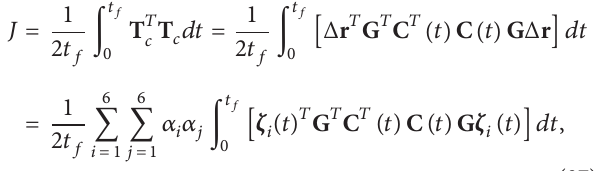
three osculating imaginary eigenvalues ±𝜔 1 (𝑡)𝑖, ±𝜔 2 (𝑡)𝑖 , and (𝑡)𝑖 for the controlled equilibrium. The ±𝜔 3